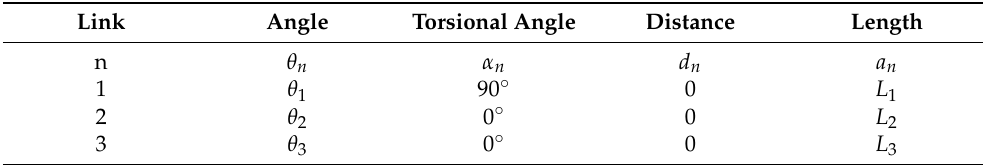
Figure 5. Schematics of D-H coordinate system of robot leg. Table 1. D-H parameters of the robot leg.